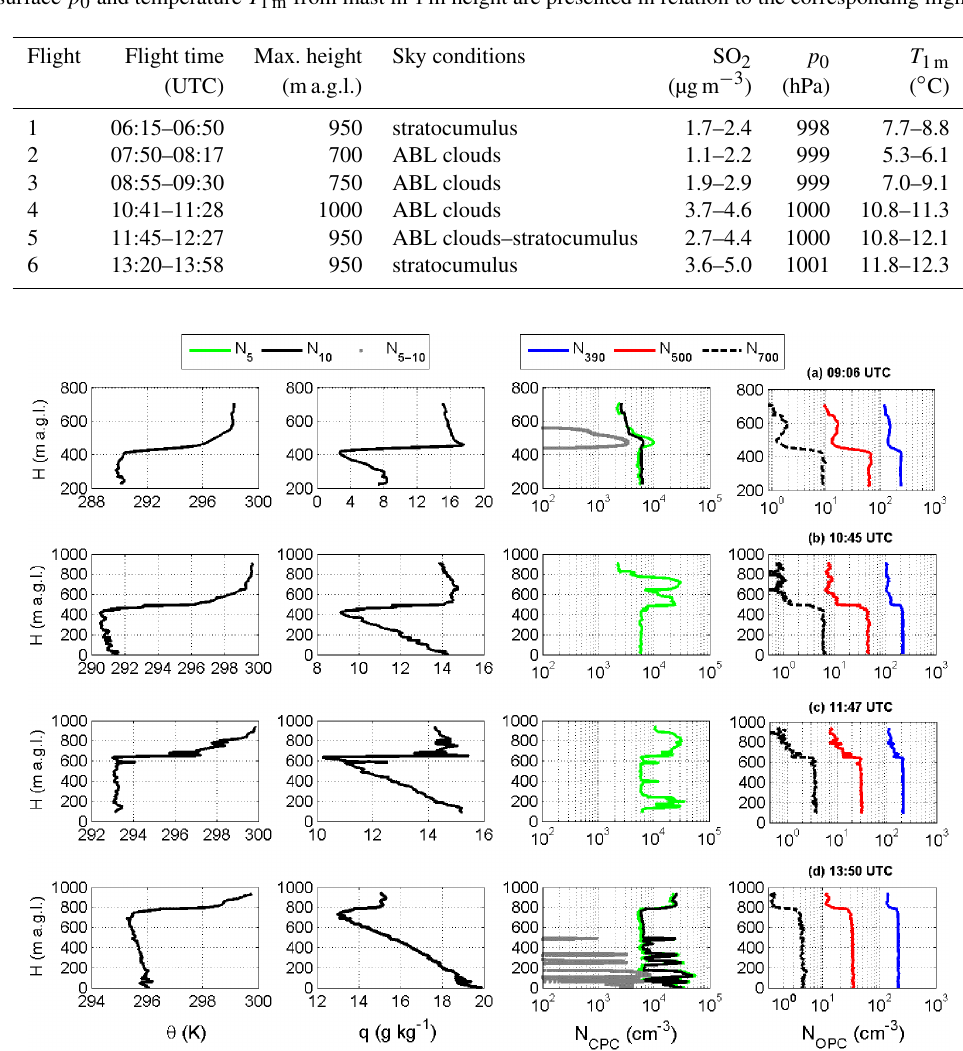
Figure 4. Vertical profiles of potential temperature θ ; water vapour mixing ratio q ; aerosol particle number concentration of ultrafine particles measured with two CPCs in the particle diameter above 5nm (green line), above 10nm (black line) and N 5–10 (grey dot). Total aerosol particle number concentration measured with the OPC in the size above 390nm (blue line), 500nm (red line) and 700nm (dashed black line) are also shown. All data were measured with ALADINA at (a) 09:06, (b) 10:45, (c) 11:47 and (d) 13:50UTC on 4 April